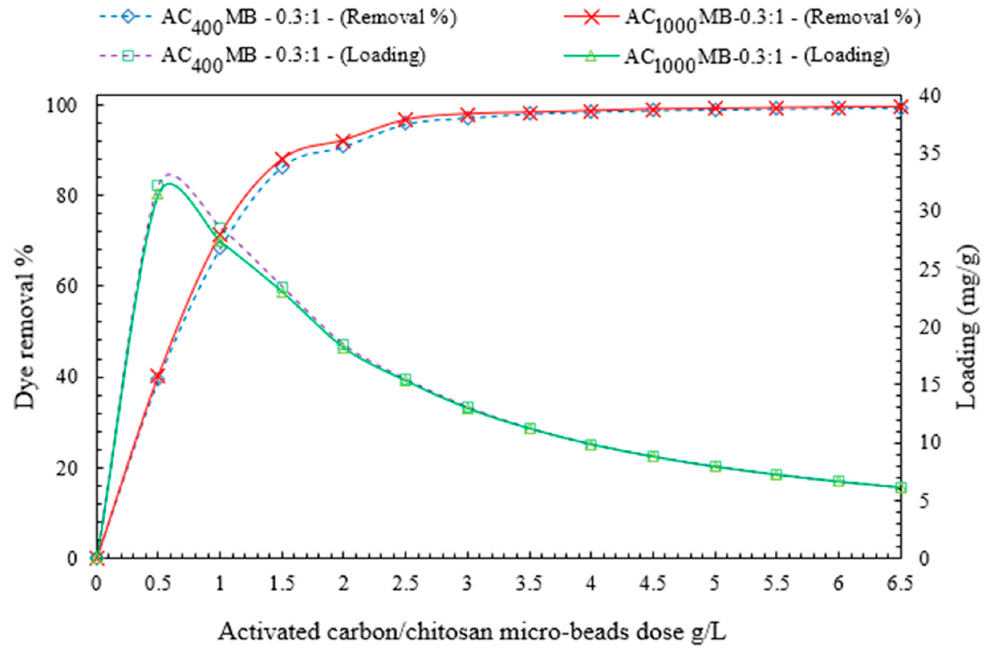
Figure 9. The effects of AC 400°C MB-0.3:1 and AC 1000 °C MB-0.3:1 doses on both dye-removal efficiency and equilibrium loading.